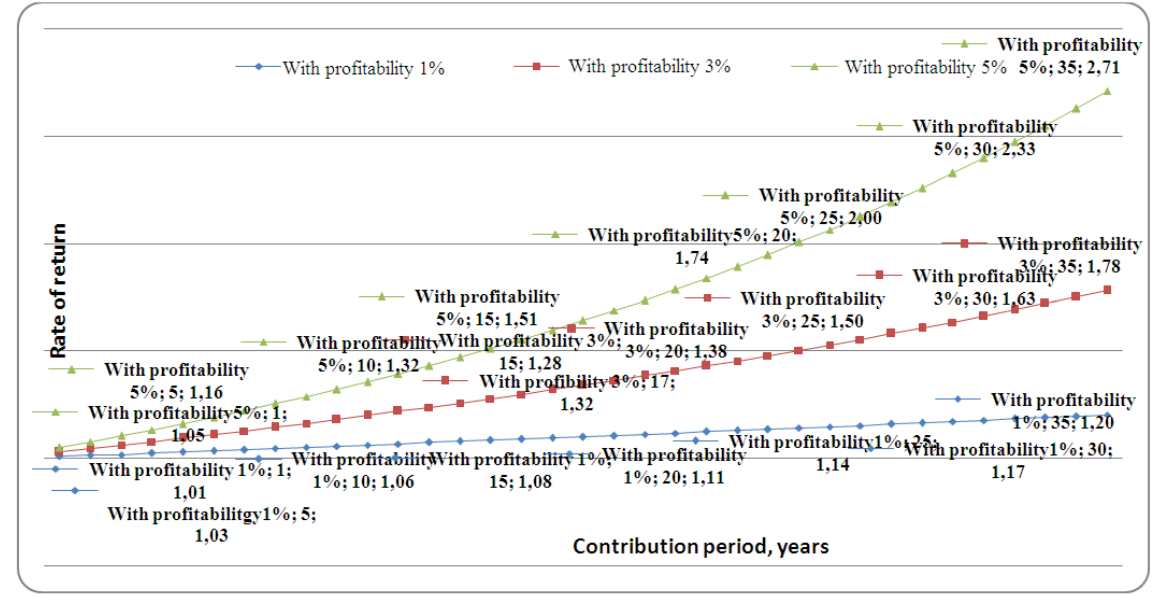
Fig. 1. Dynamics of the rates of return with different percentage yields of the accumulative system’s funds